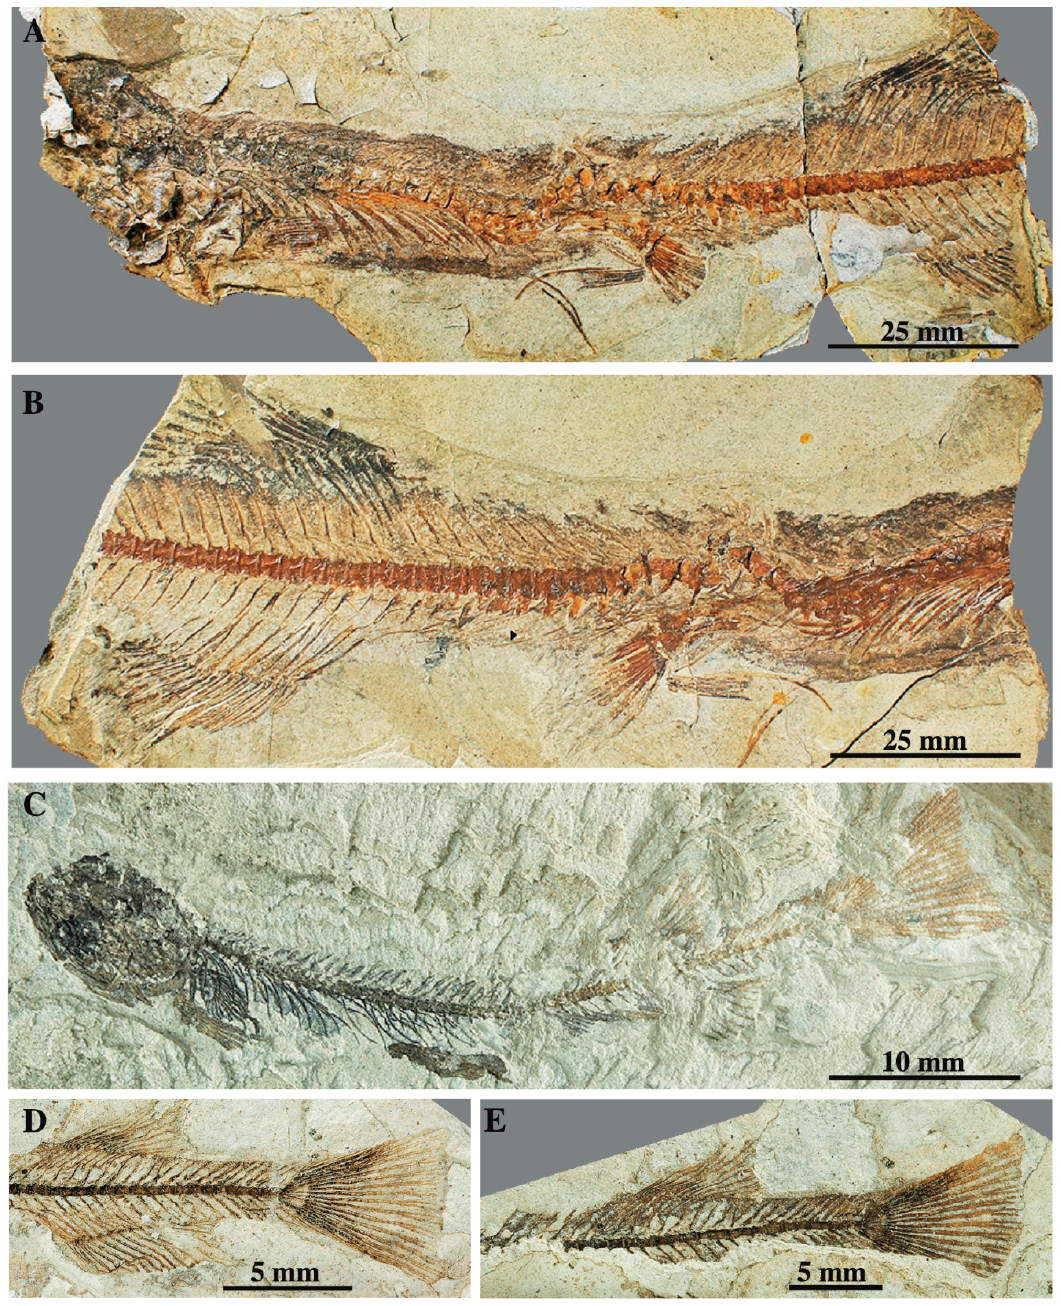
Figure 6. Frasers Gully, Kaikorai Leaf Beds, middle Miocene. Galaxias kaikorai Whitley 1956. ( A , B ), Part and counterpart of holotype (part OU6330, counterpart OU6331); ( C ), Articulated, complete adult specimen (OU22478); ( D , E ), Partially preserved fish (OU22477.2, OU22477.1).